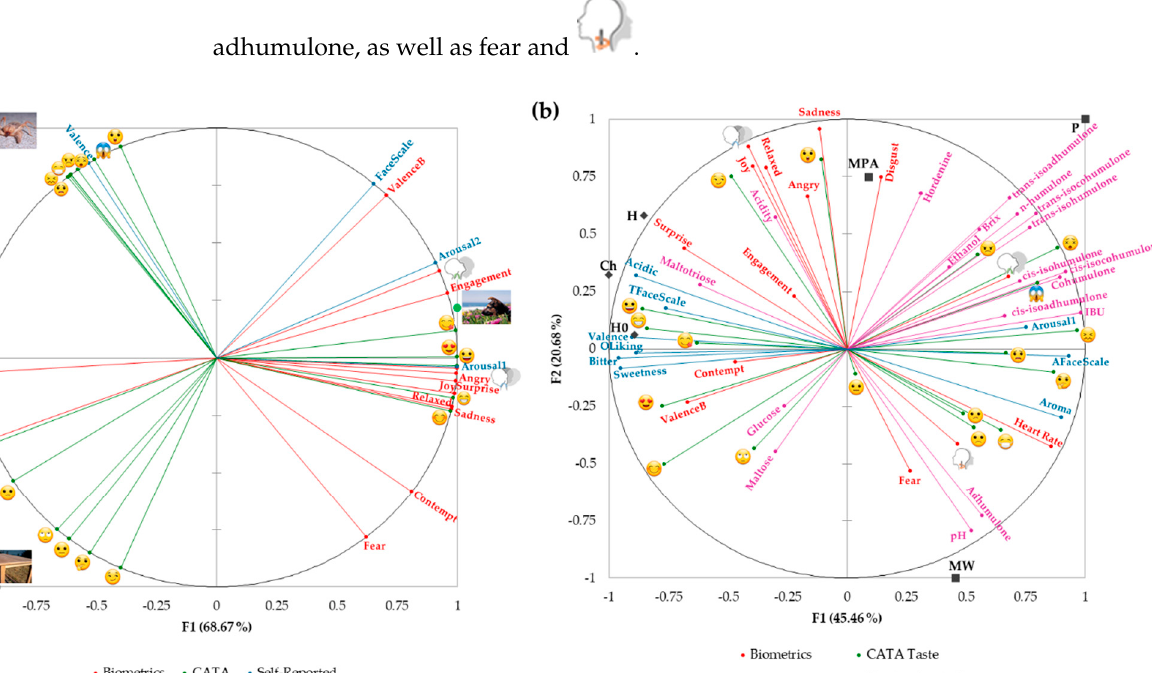
Figure 4. Multiple factor analysis (MFA) using the ( a ) check-all-that-apply (CATA) with emojis, self- reported and biometric responses from the Geneva Affective Picture Database (GAPED) images, and ( b ) physicochemical parameters, self-reported and biometric responses, and check-all-that-ap- ply (CATA) with emojis from taste attribute evaluation of the beer samples. Abbreviations of the beer samples are found in Table 1. Other abbreviations: F1 and F2: factors 1 and 2; ValenceB: valence biometrics; AFaceScale: FaceScale from aroma; TFaceScale: FaceScale from taste; IBU: international bitterness units.